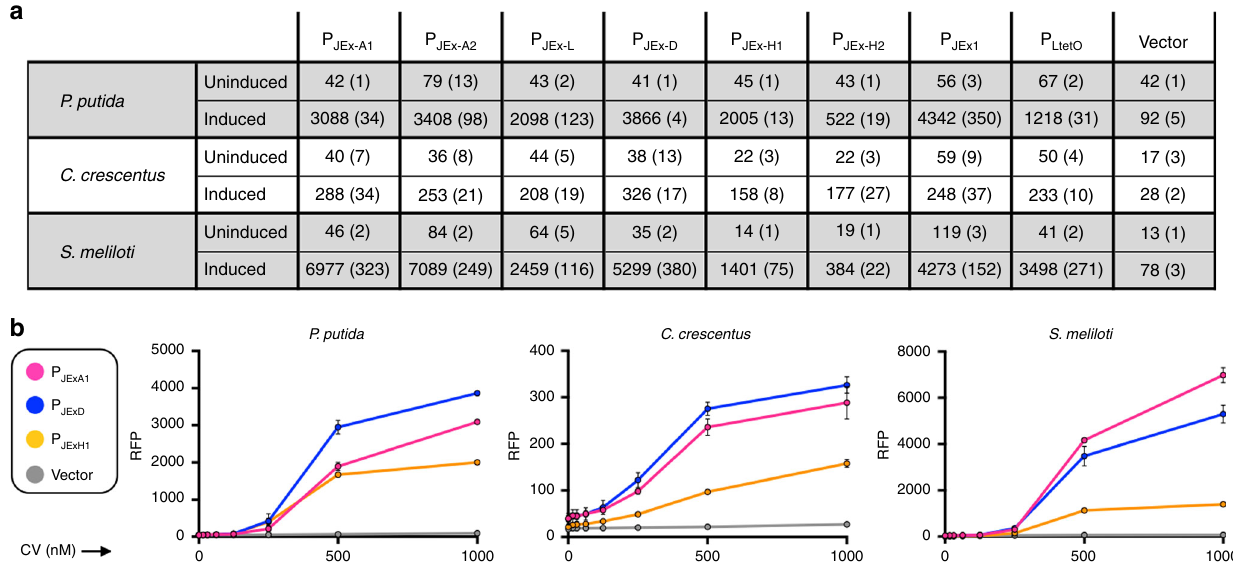
Fig. 4 P JEx -mediated transcription in non-enteric proteobacteria. a Fluorescence of P. putida KT2440, S. (Ensifer) meliloti Rm1021 and C. crescentus NA1000 cultures expressing RFP under the control of EilR-regulated P JEx promoters, either in their repressed state, or induced by 1 µ M CV. The TetR-regulated P LtetO-1 promoter 11 , induced with 100 nM anhydrotetracycline, was included for comparison. b Fluorescence of cultures expressing RFP from three P JEx promoters induced by increasing CV concentrations. Data represent the averages of plate reader measurements from two ( P. putida ) or three ( S. meliloti, C. crescentus ) independently grown stationary phase cultures, with the standard deviation indicated by error bars (curves) or in parentheses (table). Fluorescence values are in arbitrary units and cannot be compared directly across different hosts because different instruments were used for measurements